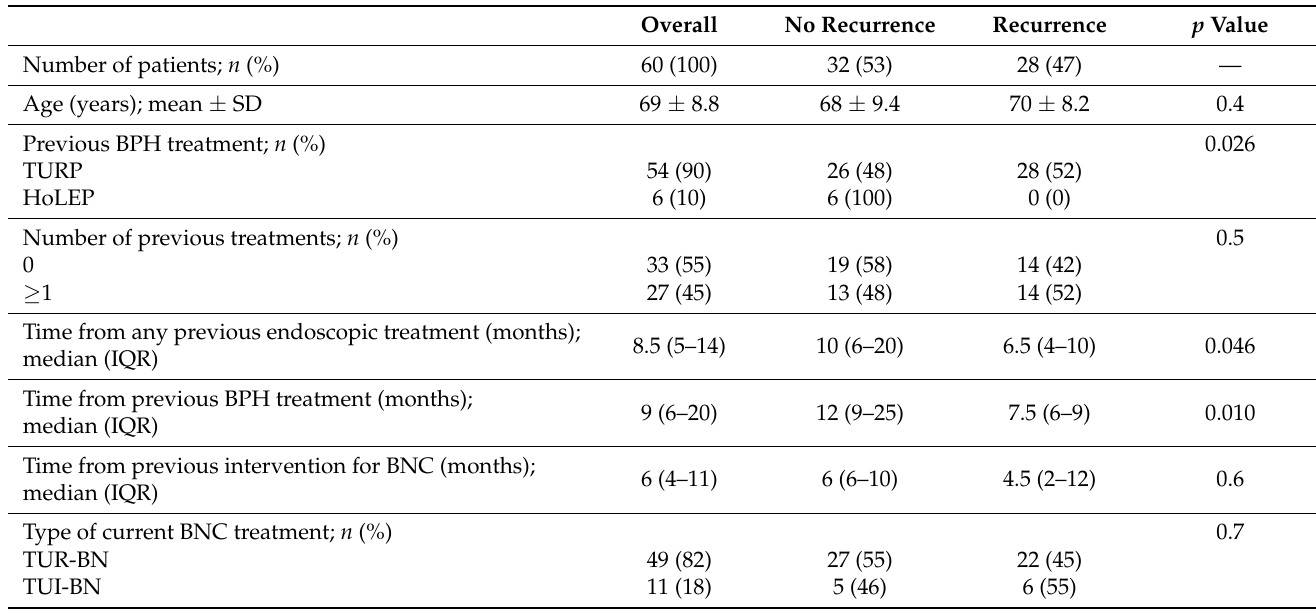
Table 1. Patient characteristics of 60 men who underwent endoscopic treatment for bladder neck contracture stratified by recurrence